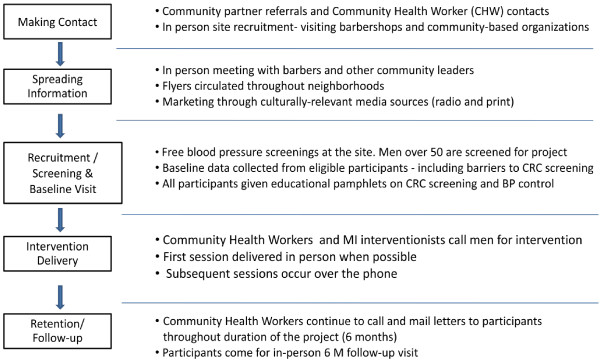
Study procedures.